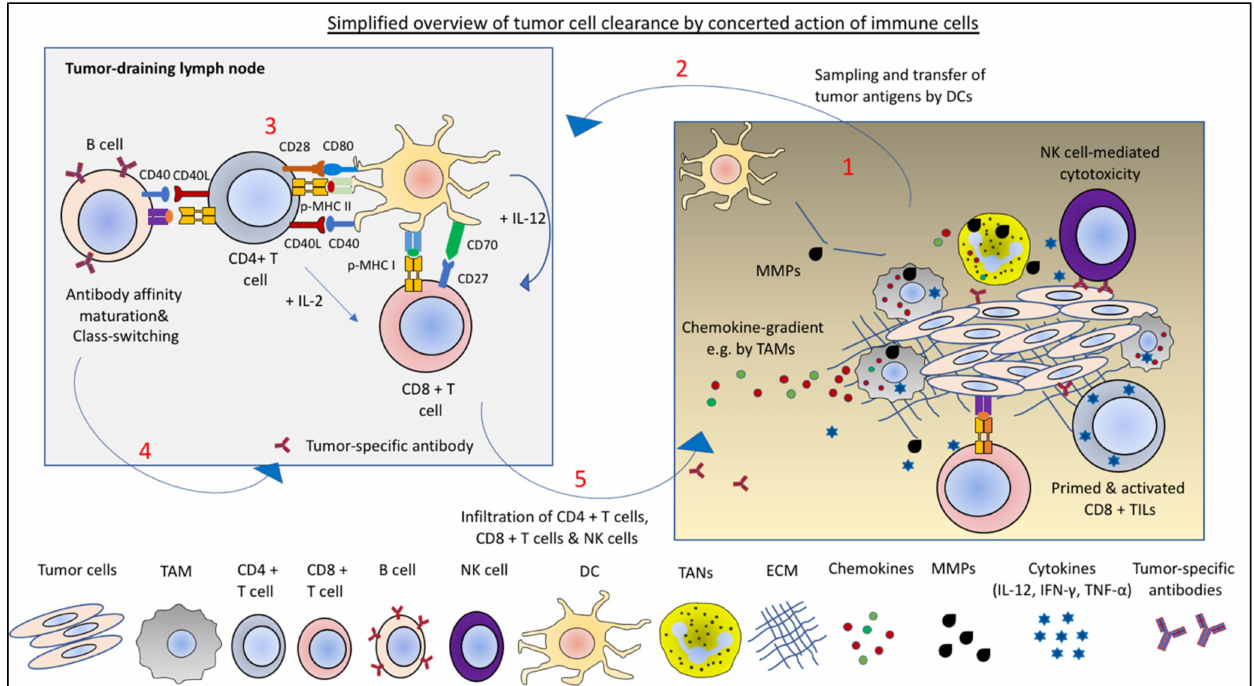
Figure 1. Tumor cell clearance by the concerted action of immune cells. ( 1 ) Sampling of tumor antigens by DCs and ( 2 ) antigen-presentation in tumor-draining lymph nodes activates CD4+ T cells and CD8+ T cells. ( 3 ) Priming and activation of CD8+ T cells further requires licensing of DCs by CD4+ T cells and the cytokines produced by activated CD4+ T cells. ( 4 ) Activated T cells help B cell maturation, antibody class-switching, and production of tumor-specific antibodies. NK-cell mediated cytotoxicity can take advantage of the tumor-specific antibodies. ( 5 ) Activated, primed cells infiltrate the tumors. The tumor infiltration of activated immune cells require chemokine matching as well as ECM degradation and remodeling by